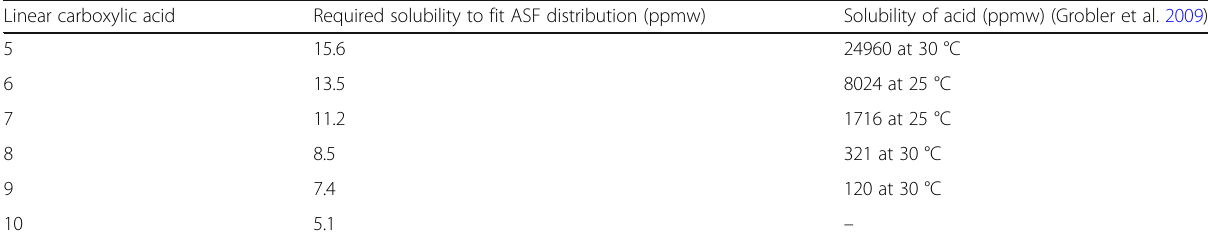
Table 6 Solubility of carboxylic acids required in aqueous media for fit to ASF distribution Linear carboxylic